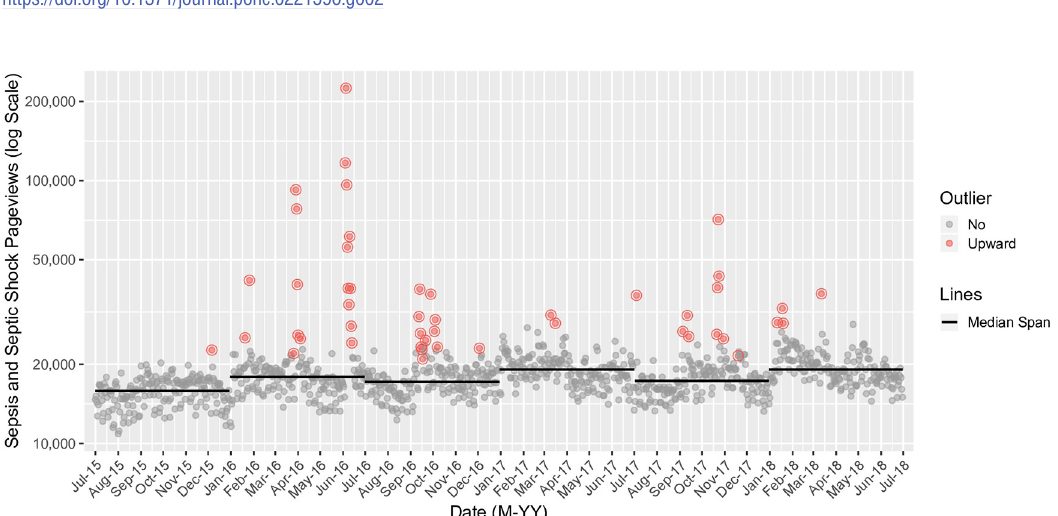
Fig 2. Sepsis Wikipedia user pageviews by language localization. To improve legibility, only the top 15 languages are depicted. The remaining 50 are summarized in the “Other” category. The legend appears in descending numerical order with “Other” listed last.